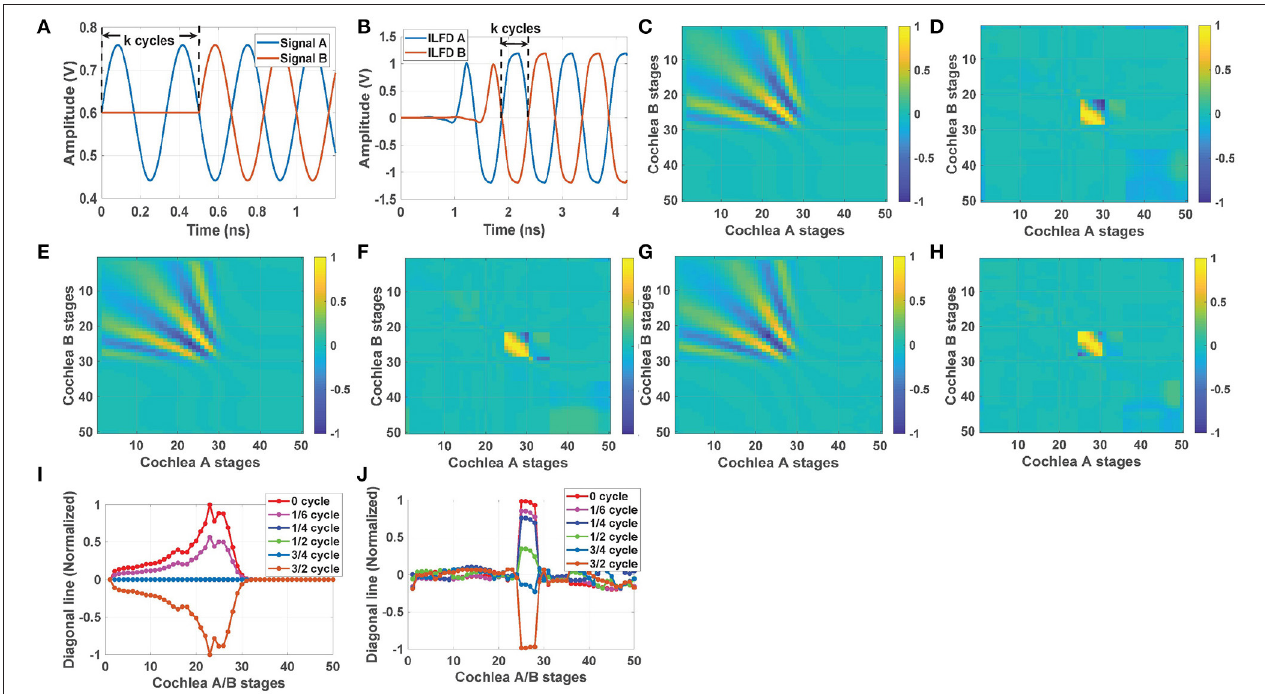
FIGURE 5 | (A) Two 3 GHz sinusoidal inputs at − 6 dBm with an ITD of k cycles between them, and (B) the simulated ITD at the injection-locked frequency divider (ILFD) outputs for stage n best = 23. Left column: simulation results showing the time-averaged outputs of the cochlear cross-correlogram network (using the un-encoded cochlear voltages V out ( n )) for ITDs of (C) k = 0, (E) k = 1 phase-encoded ILFD outputs for the same ITDs, namely (D) k = 0, (F) k = 1 using (I) the un-encoded cochlear outputs (left column) and (J) the frequency- and phase-encoded outputs (right